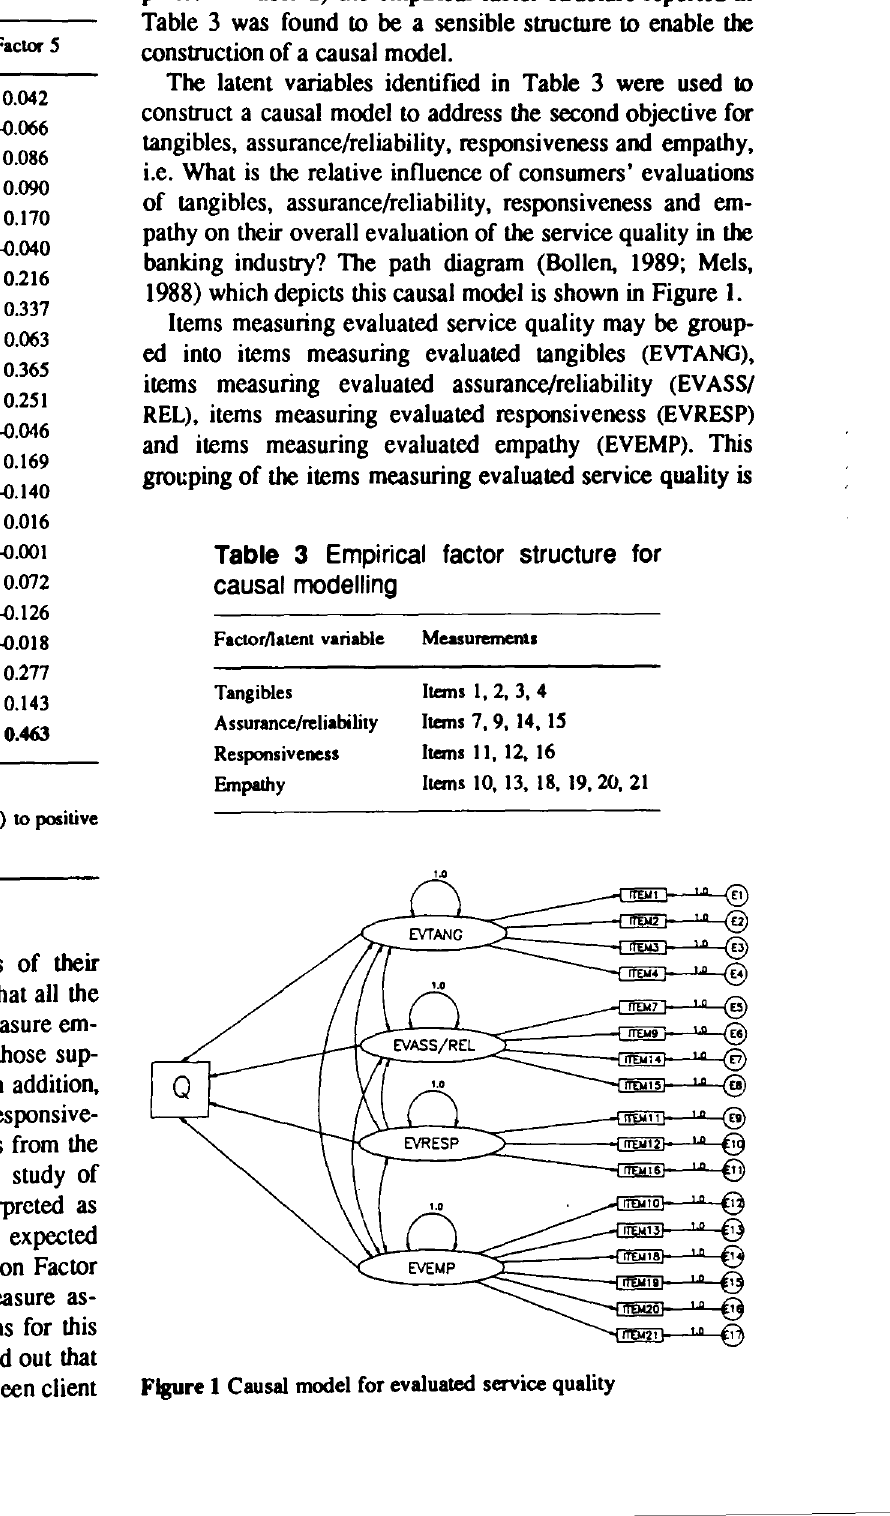
Table 2 Rotated factor loadings 1 for evaluated service quality dimensions